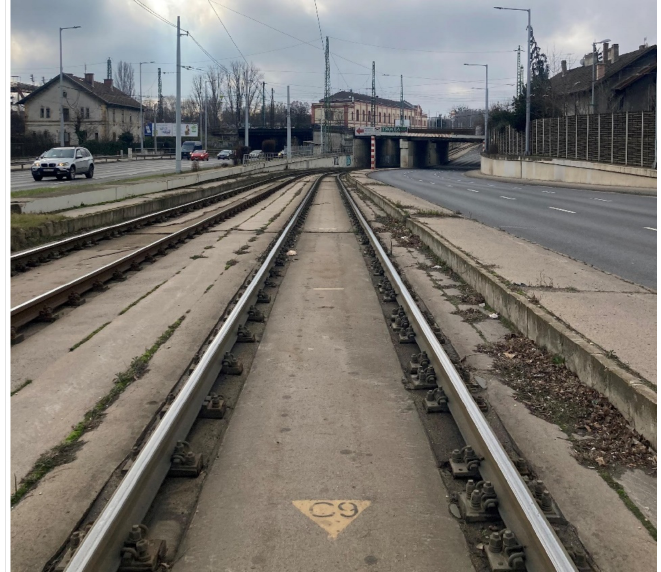
Figure 7. Photo of Section #6 (own photo).